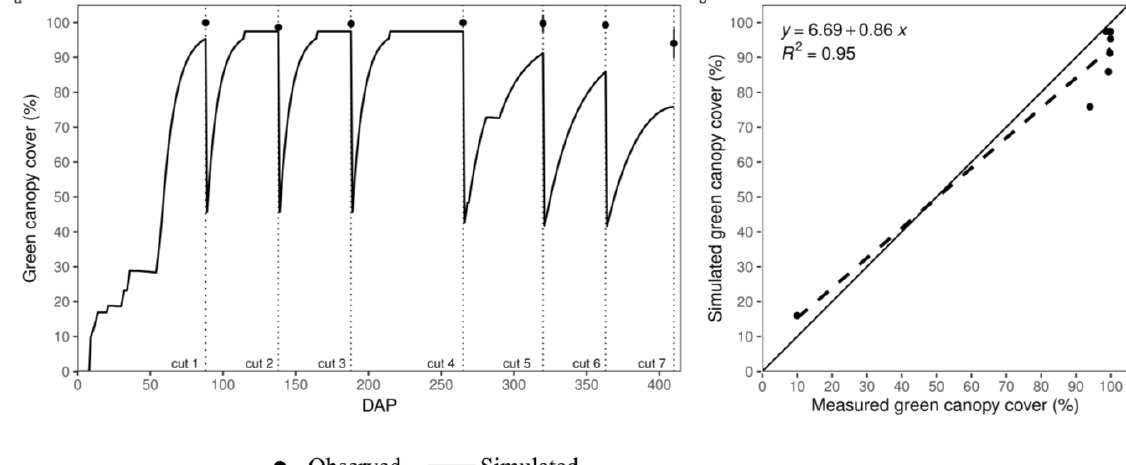
Figure 3. Simulated and observed values of crop canopy cover (CC) ryegrass ( Lolium perenne L. ) during model calibration (C1-Irrigation: full irrigation treatment in the first cropping season of ryegrass). ( a ) Measured and simulated CC during the growing season; error bars are standard deviations for measured data; black dashed line shows the cutting day; ( b ) regression of measured and simulated CC. Black diagonal lines represent 1 ∶ 1 lines.